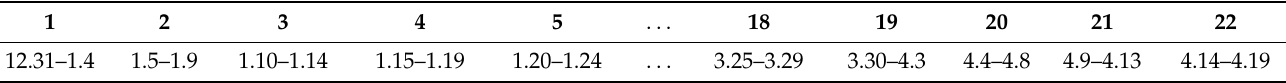
Table 2. The divide of 22 groups of